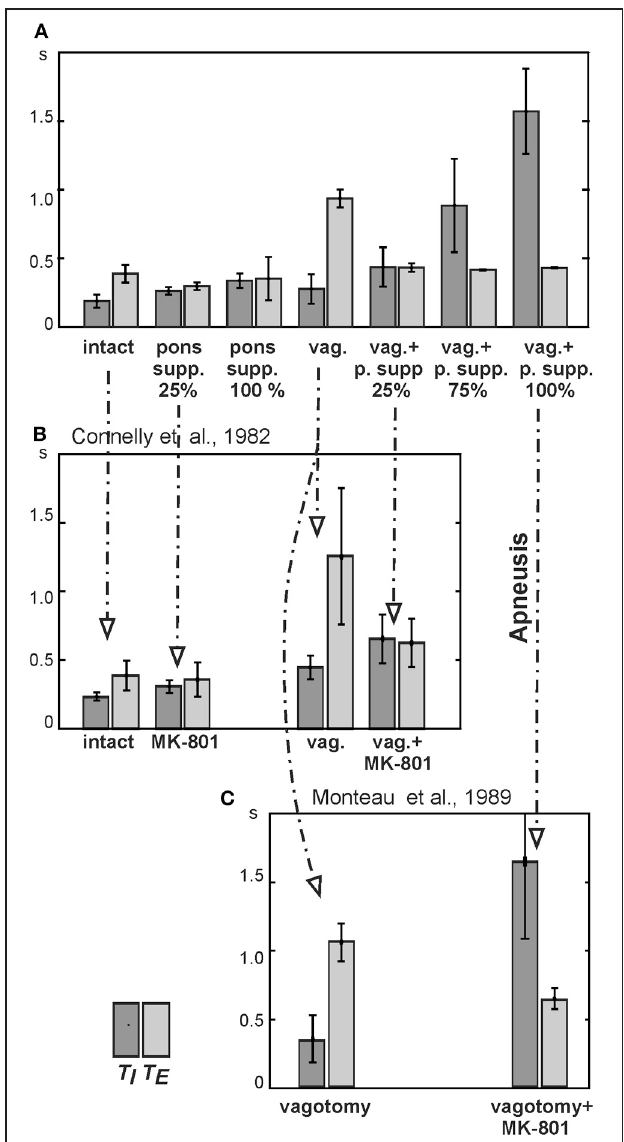
FIGURE 6 | Changes in the durations of inspiration ( T I ) and expiration ( T E ) following pontine suppression and/or vagotomy. (A) Changes in T I and T E following the simulated pontine suppression at different degrees (25%, 75%, and 100%) before and after (vag. + ) vagotomy. (B) Changes in T I and T E in the study of Connelly et al. (1992): diagrams are built for spontaneously breathing Wistar rats under control conditions and after administration of NMDA blocker MK-801 before and after vagotomy. (C) Changes in T I and T E in the study of Monteau et al. (1990) performed in anaesthetized vagotomized rats using MK-801